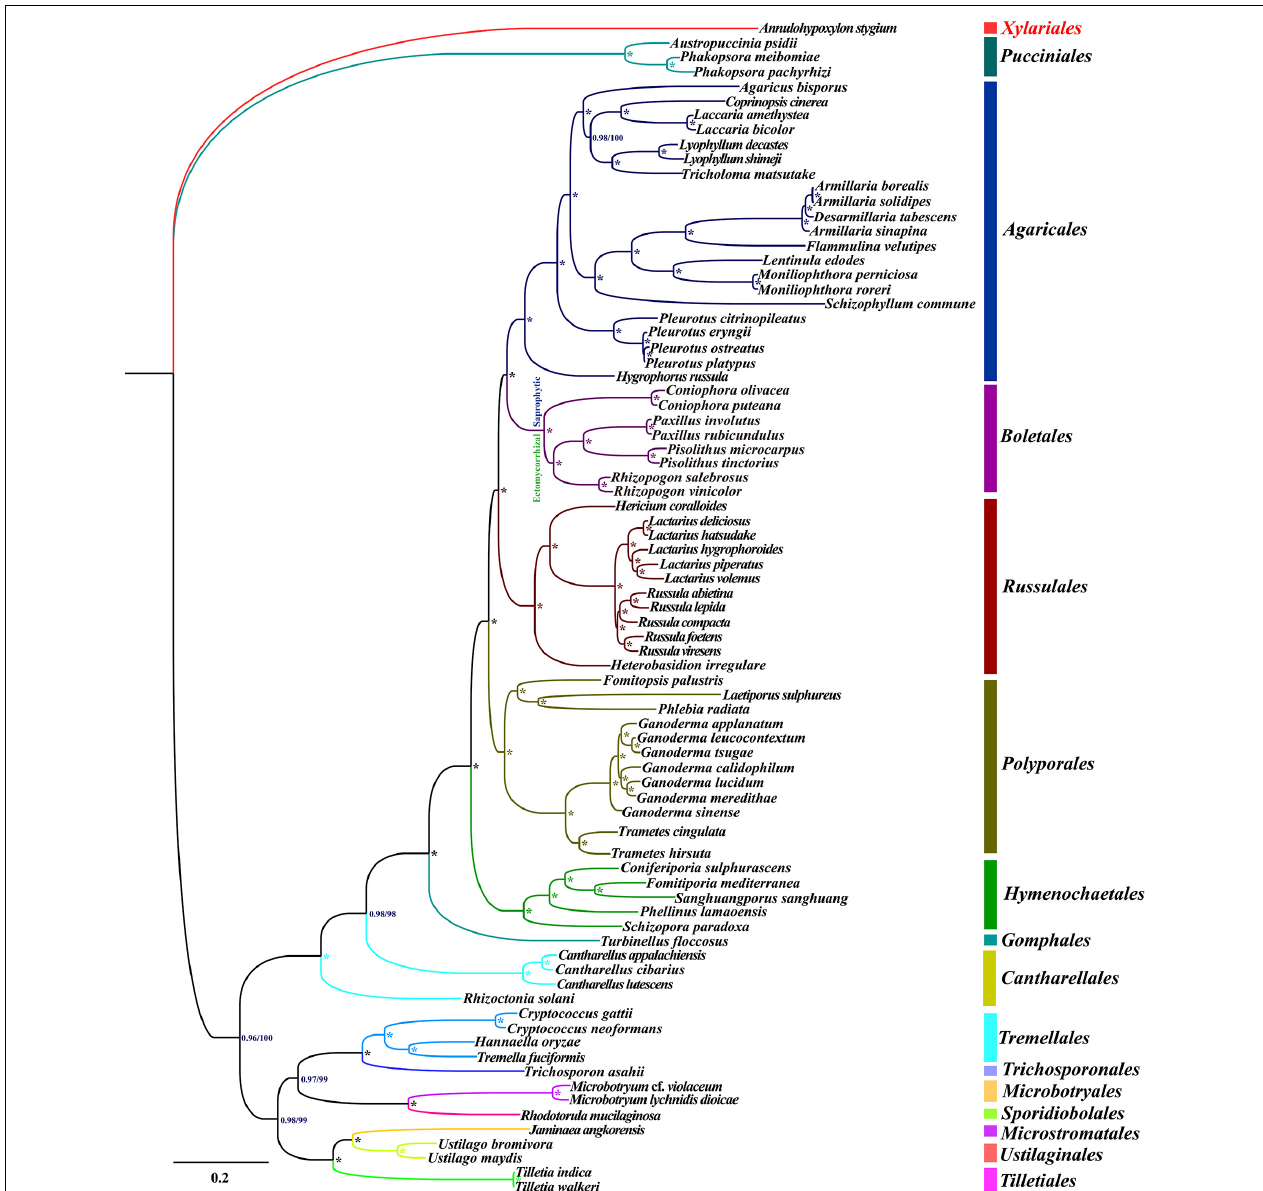
FIGURE 8 | Molecular phylogeny of 79 Basidiomycota species based on Bayesian inference (BI) and Maximum likelihood (ML) analysis of 15 protein coding genes and two rRNA genes. Support values are Bayesian posterior probabilities (BPP, before slash) and bootstrap values (BS, after slash). The asterisk indicates that the BPP value is one and the BS value is 100 of the branch. Species and NCBI accession numbers for mitogenomes used in the phylogenetic analysis are provided in Supplementary Table 6